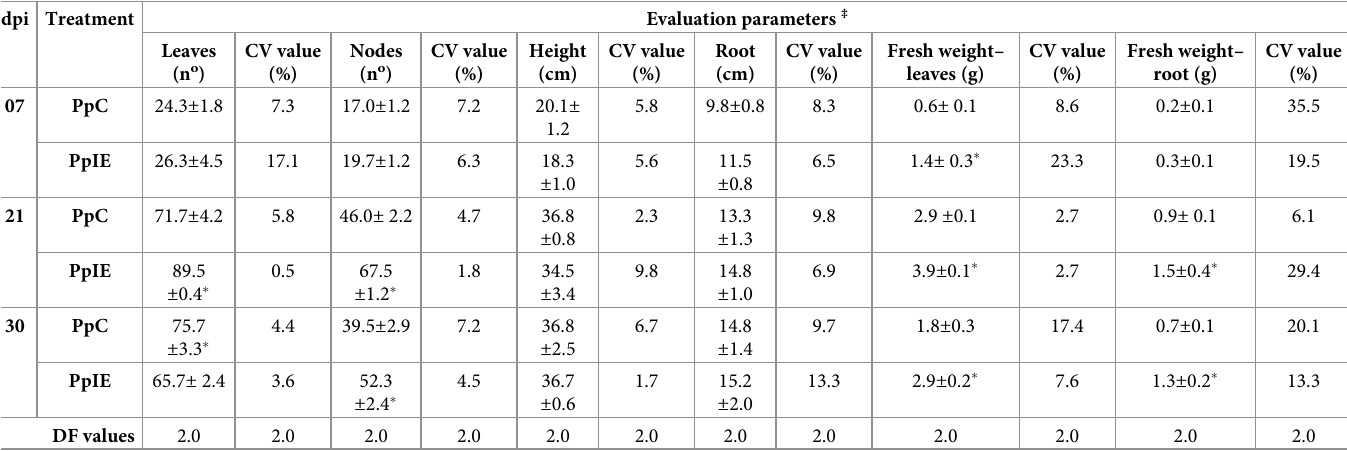
Table 1. Developmental parameters of Peperomia pellucida after inoculation with Enterobacter asburiae . dpi